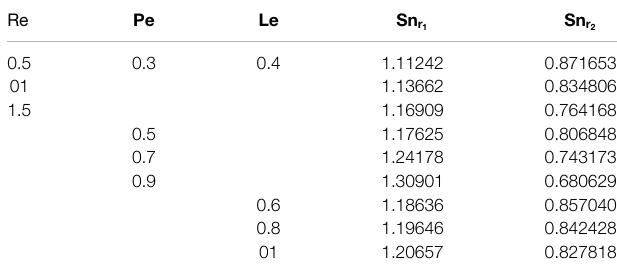
TABLE 5 | Effects of parameters Re, Pe , and Le on motile density number Sn x